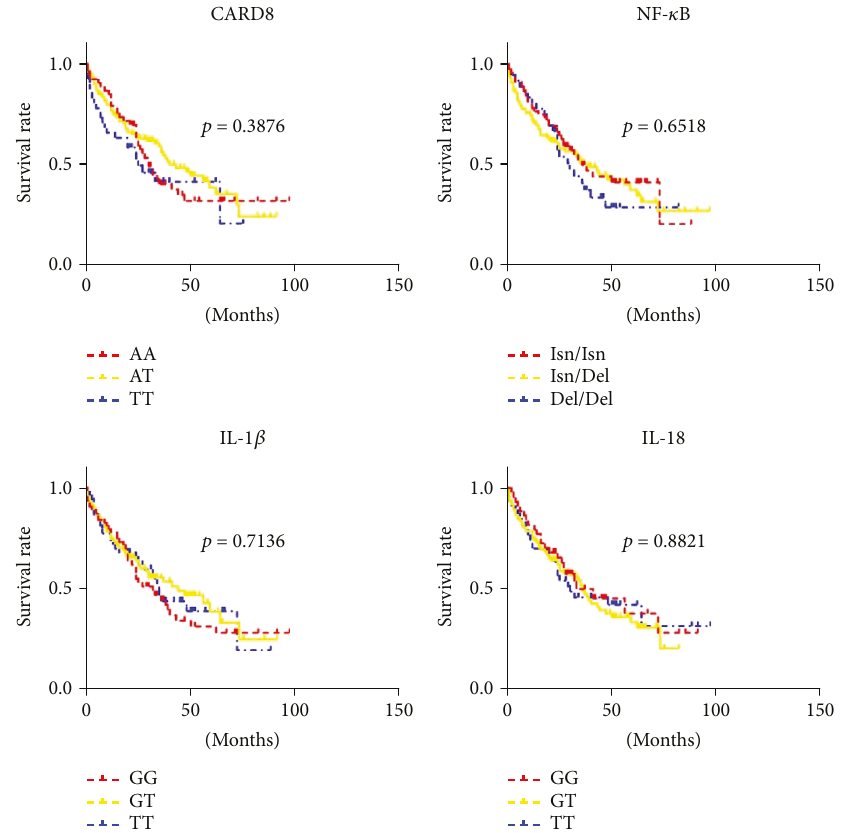
Figure 1: Survival curves of CARD8 (rs2043211), IL-1 β (rs16944), IL-18 (rs1946518), and NF- κ B-94 ins/del ATTG genotypes in MM patients. Log-rank P values compared with the di ff erent genotypes are displayed, and no signi fi cant di ff erence was found for the overall survival of MM patients with the above